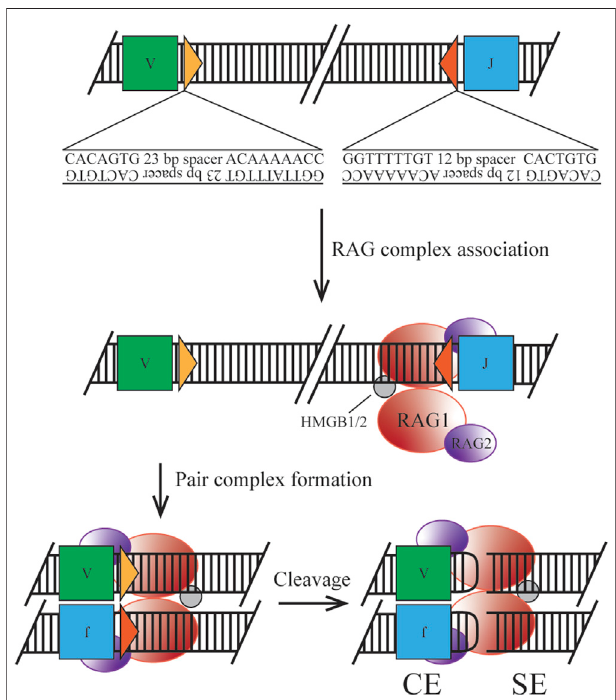
FIGURE 1 | Classical mechanism of RAG initiated cleavage. Ig loci segments are fl anked by 12/23 RSS containing a heptamer and nonamer sequence for RAG complex association. Synapsis of two RSS sites allows for nicking,cleavagebytransesteri fi cation,andhairpinformationtoformthe post cleavage